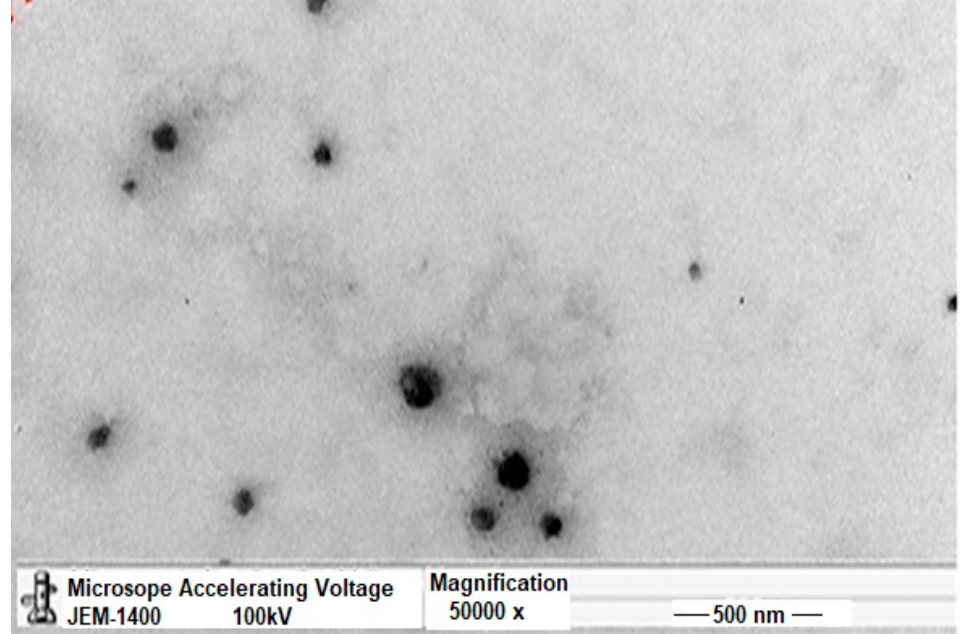
Figure 1. TEM image of selected TCR-loaded SPL formulation (F3 OA 1).